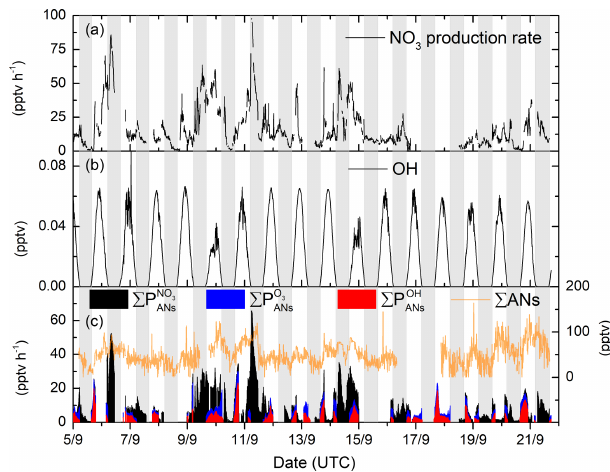
Figure 3. (a) NO 3 radical production rate from reaction of NO 2 and O 3 . (b) calculated OH mixing ratio; see Sect. 2. (c) Production rate of ANs from OH (red), O 3 (blue) and NO 3 radicals (black) and the (cid:54) AN mixing ratio (orange